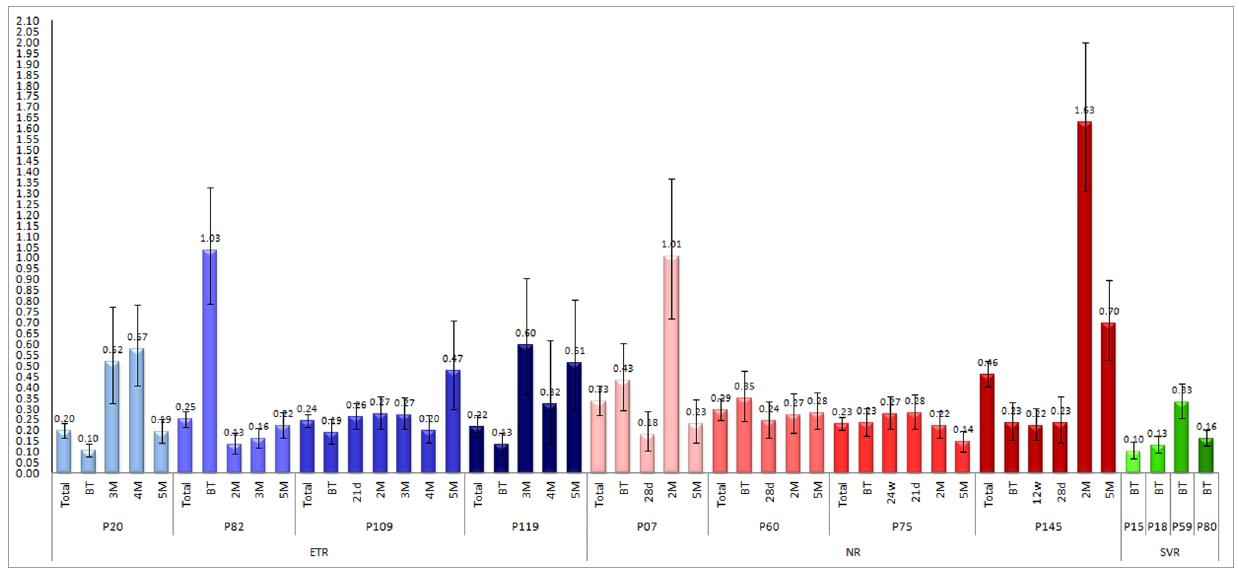
Figure 4. v per patient. v rates for each patient (Total) and for each time point. BT-Before treatment; w-weeks; d-days; m-months.